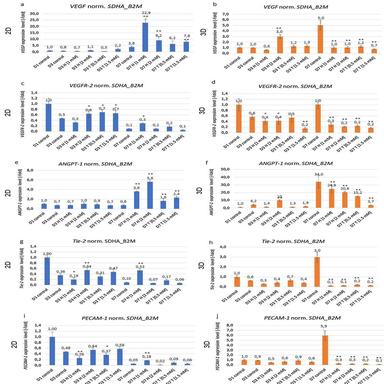
Impact of LPS and/or resinous monomer treatment on the expression of angiogenesis-related markers (VEGF, VEGFR-2, ANGPT-1, TIE-2 and PECAM-1) in 2D HUVEC/SCAP co-cultures (a, c, e, g, i) as compared to the HUVEC/SCAP seeded 3D COL/FIB hydrogels representing the lower compartment of DentCytoTool (b, d, f, h, j). Angiogenesis-related gene expression was evaluated by Real-time PCR at D1, D3 and D7 after LPS pre-treatment followed by exposure to HEMA or TEGDMA . Values are means (±SD) of three independent ex